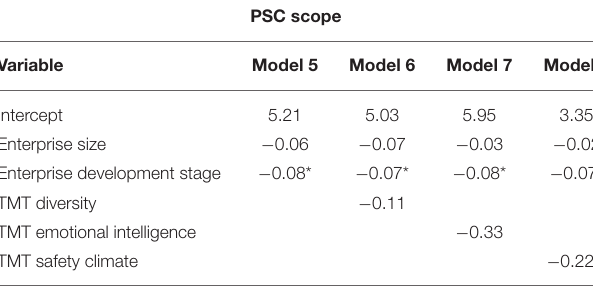
TABLE 4 | Regression analysis: Effects on PSC scope.